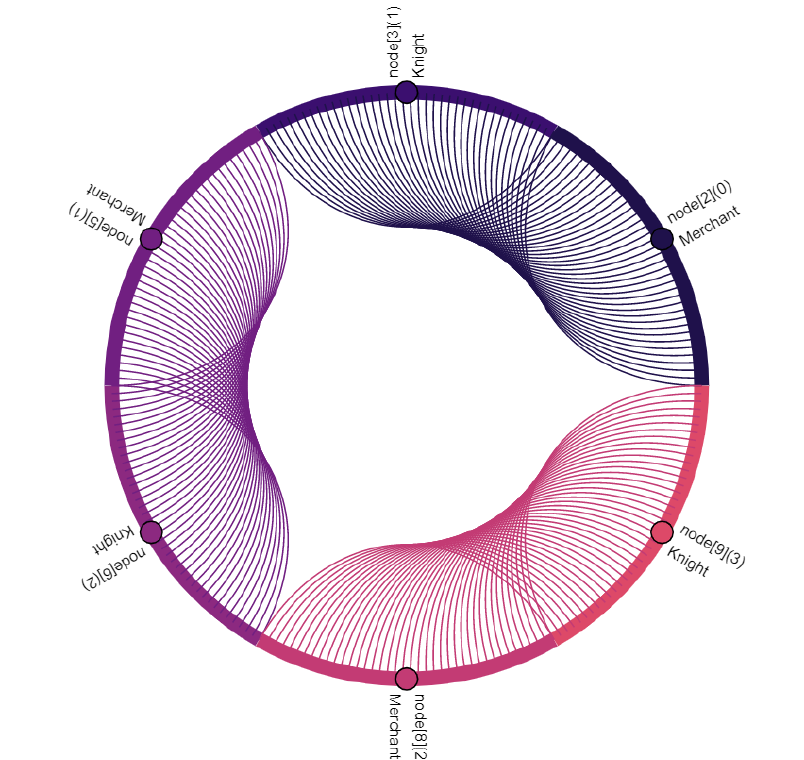
Figure 8. Merchants of each vassalage send their collected vassalage data to the knight of the following